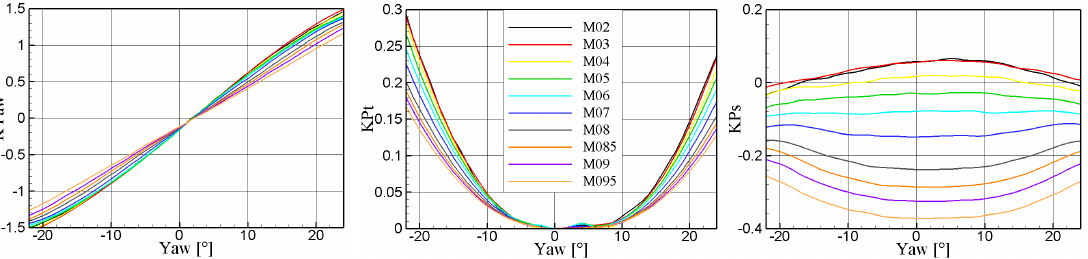
Figure 9. 2D FRAPP calibration coefficients for varying Mach number and yaw angle.